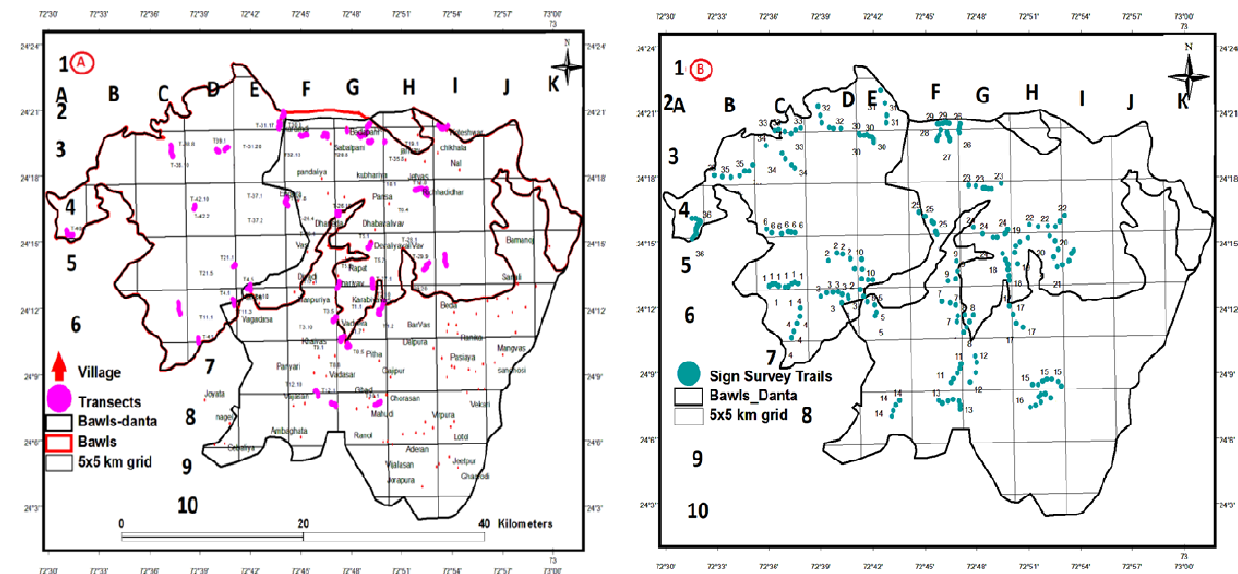
Fig. 1. A-Vegetation transects location in grid of study area; B- Sign survey trails in grid of study area